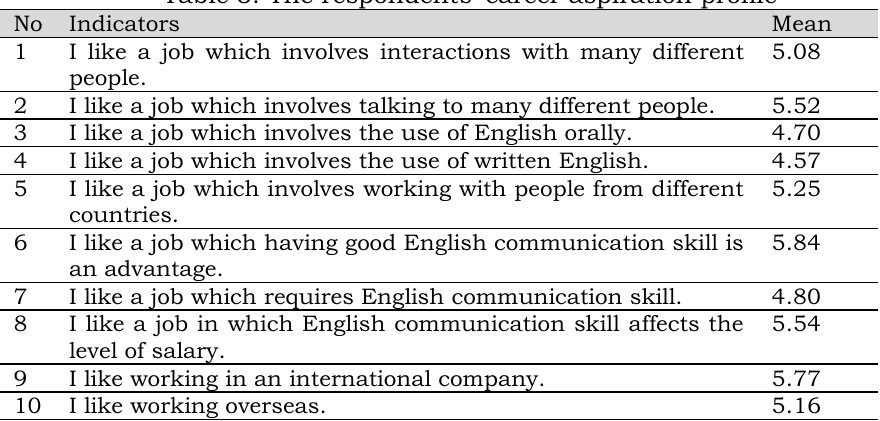
Table 3. The respondents’ career aspiration profile